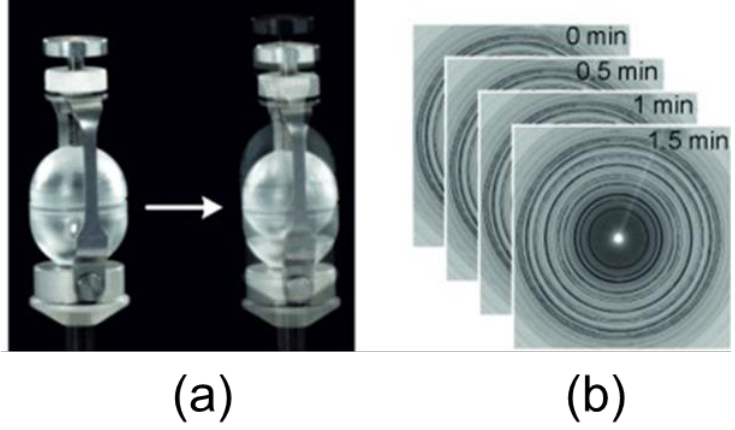
Figure 7. ( a ) 10 mL Perspex grinding vessels stationary and vibrating, ( b ) measured XRD images recorded every 30 s. Reprinted with permission from [55]. Copyright 2014, John Wiley and Sons.